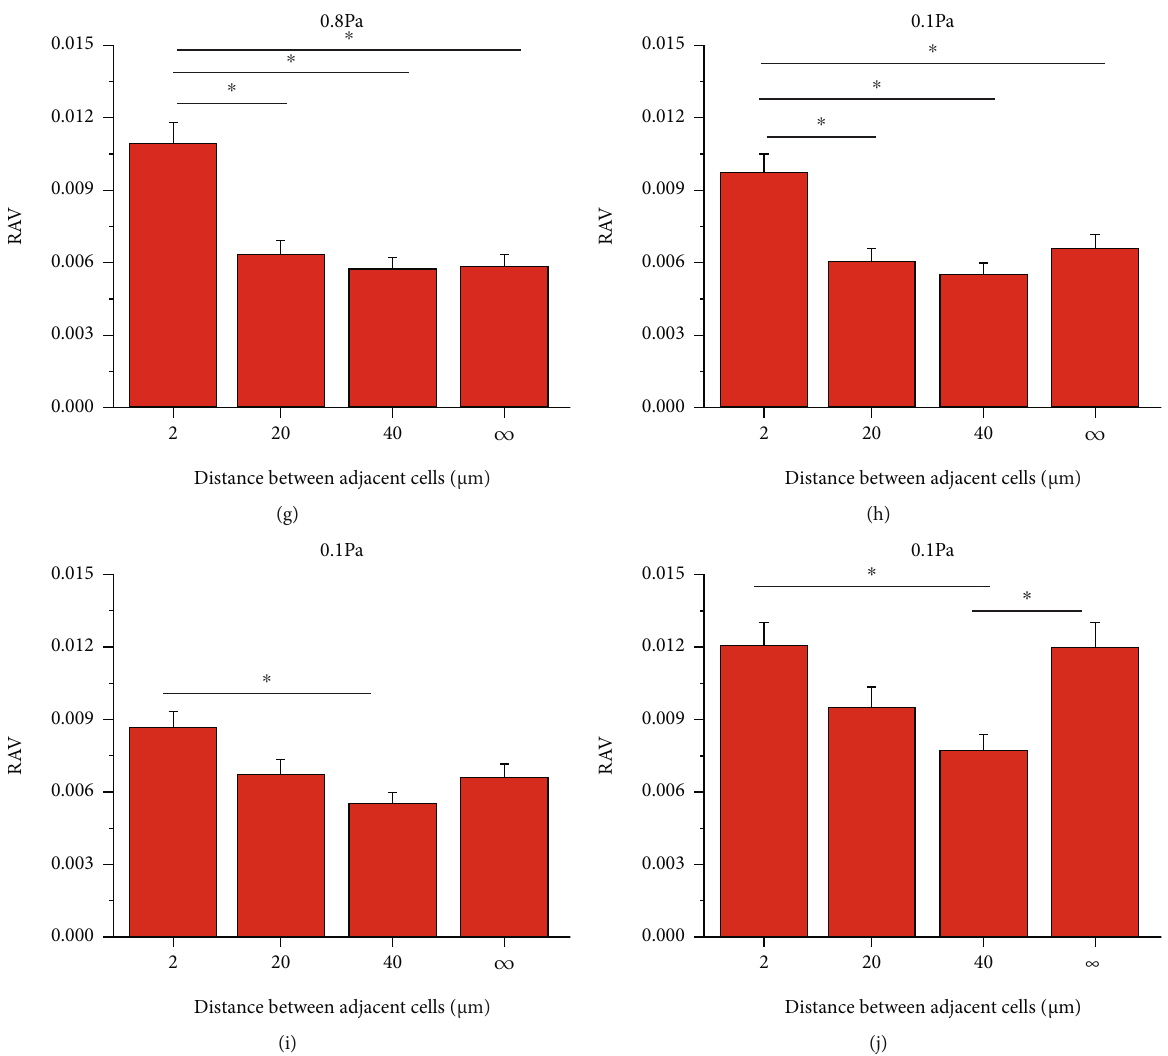
Figure 4: RAV on hexagonal closely packed cells. (a) Schematic of hexagonal closely packed cells with di ff erent cell spacings. (b, e, and h) RAV on central cell at three FSS magnitudes under constant FSS gradient of 0.05Pa/mm. (c, f, and i) RAV on central cell at three FSS magnitudes under constant FSS gradient of 0.1 Pa/mm. (d, g, and j) RAV on central cell at three FSS magnitudes under constant FSS gradient of